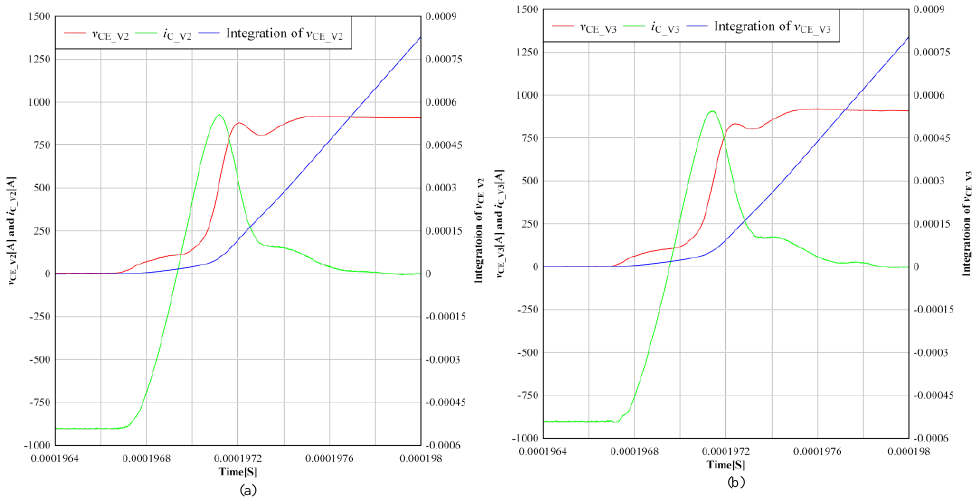
Figure 13. Stray inductance measurements of the upper and lower switches for FF1400R17IP4. ( a ) The lower switch test waveforms. ( b ) The upper switch test waveforms.